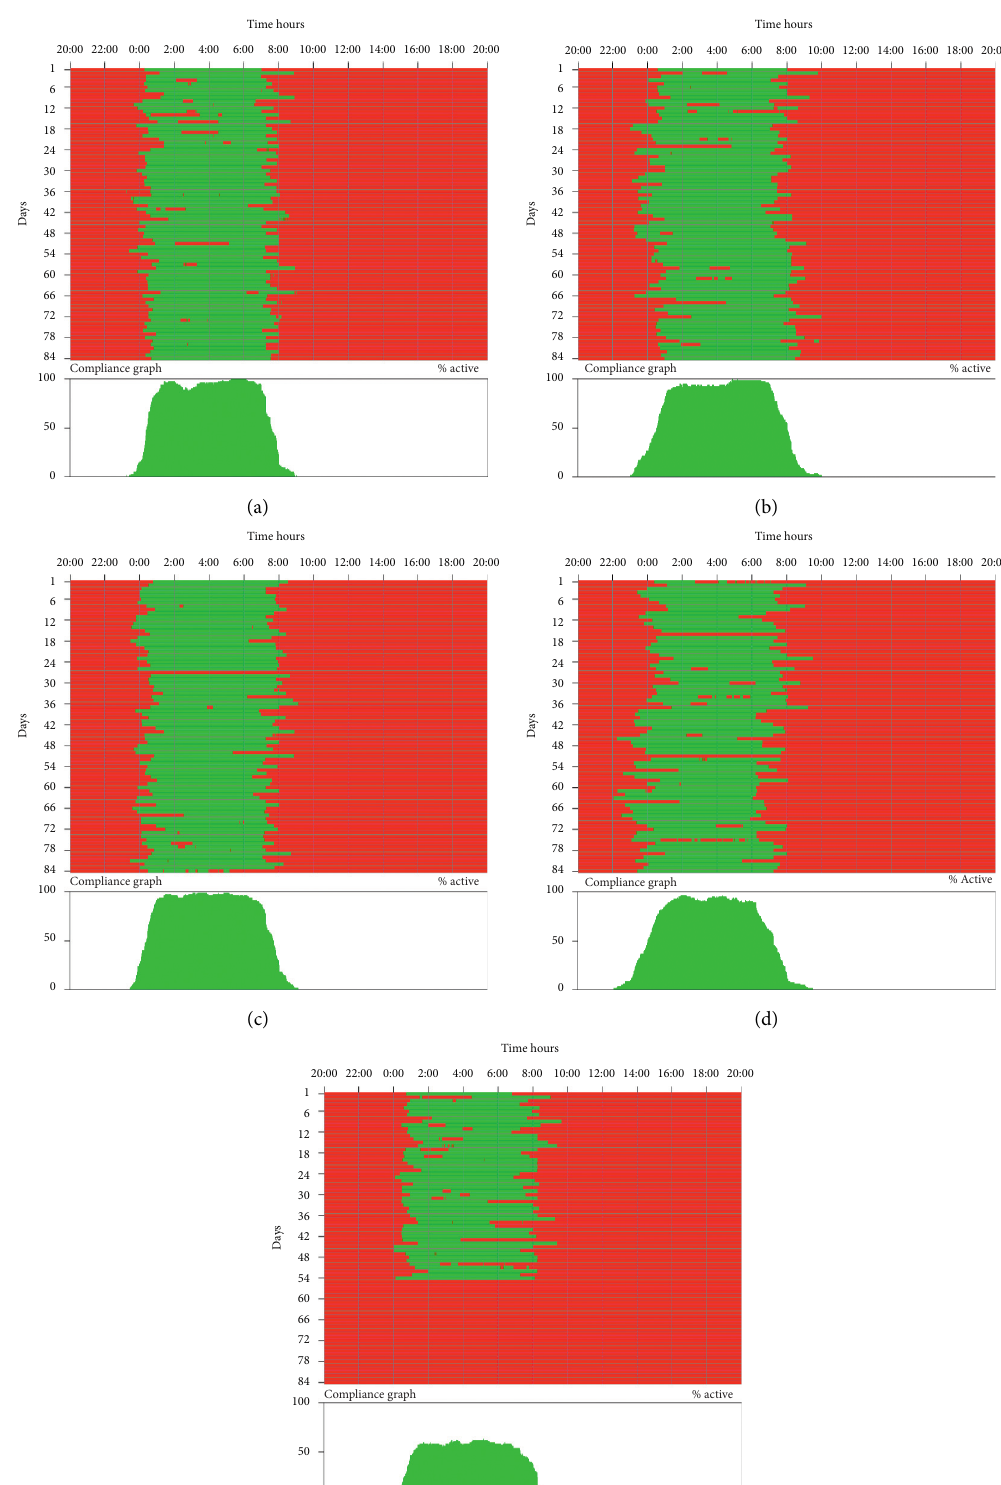
Figure 3: The study mask wear data from a patient who completed mask wear for over 1 year. It can be seen from this patient that mask wear is high throughout and it was in line with the patient-reported sleep hours making compliance high and consistent. Note that this patient required an additional 5th mask because of clinic delay of exit visit due to